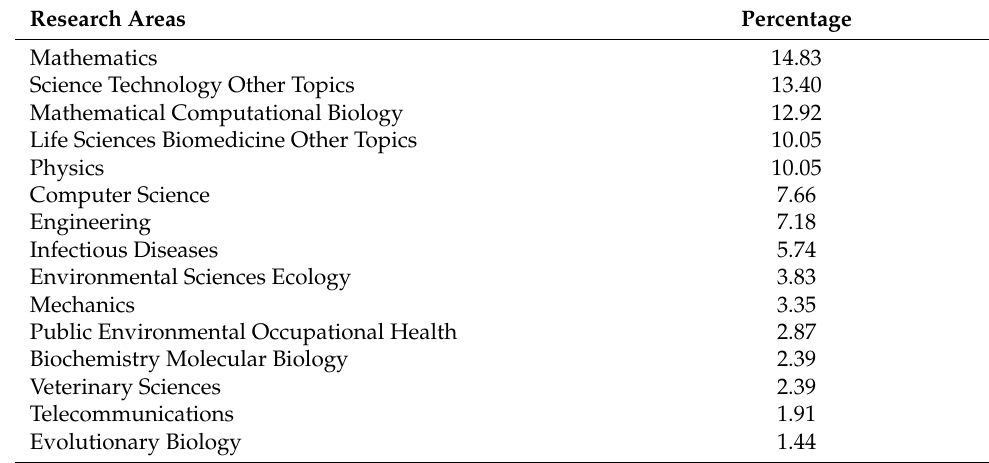
Table 4. Research areas of publications.